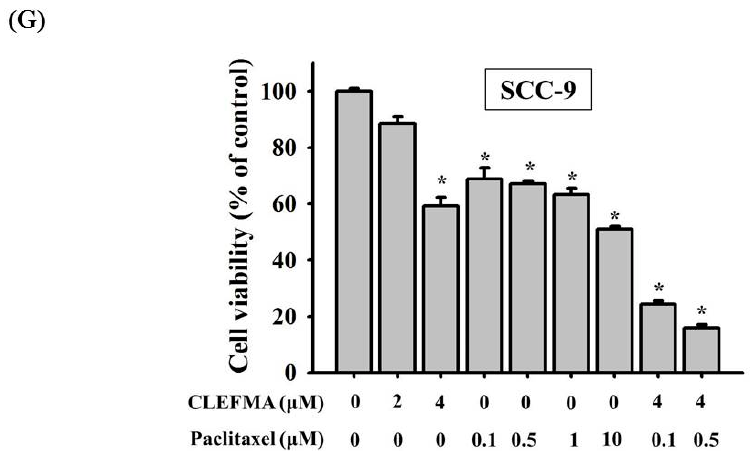
Figure 1. Inhibitory effects of CLEFMA on viability and formed cell colonies in human OSCC cells. ( A ) The molecular structure of CLEFMA. ( B ) SG cells, ( C ) HSC-3, and ( D ) SCC-9 cells treated with 0–16 µ M CLEFMA for 24 h and then subjected to MTT cell viability assay. ( E ) Digital image showing colonies produced by HSC-3 and SCC-9 cells, treated with 0–8 µ M CLEFMA with colony formation assay. ( F ) The quantification of formed cell colonies. ( G ) SCC-9 cells were treated with paclitaxel (taxol) alone or in combination with CLEFMA and then subjected to MTT assay. Data represent the average ± SD from three independent experiments. * p < 0.05 compared with the DMSO control